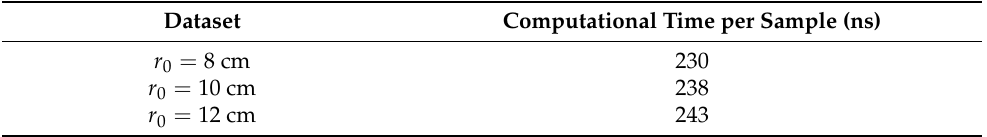
Table 2. Means of the computational time needed by the MLP model per sample for each test dataset.